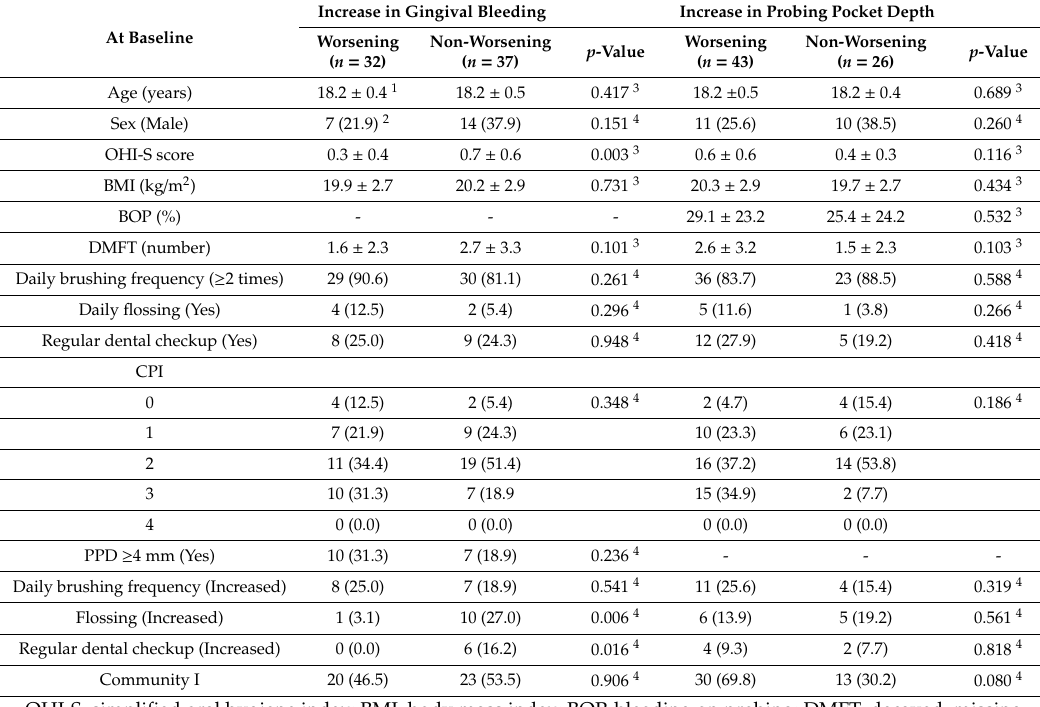
Table 2. Comparison between worsening and non-worsening groups (increase in bleeding on probing (BOP) and probing pocket depth) among randomly selected young adults ( n = 69). At